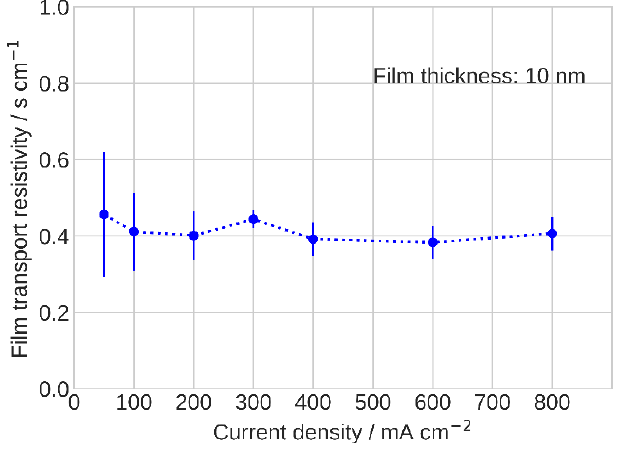
Figure 7. Ionomer film oxygen transport resistivity.